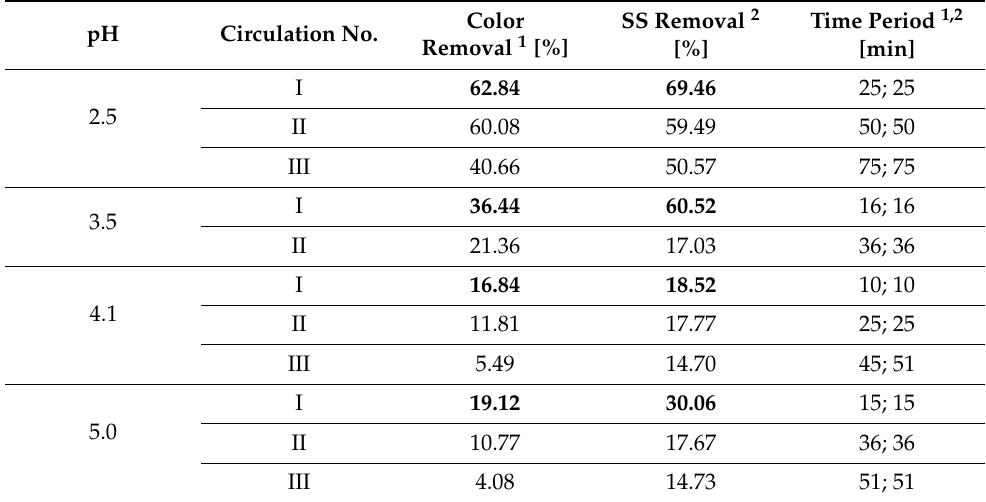
1 color removal and 2 SS removal and the corresponding time periods (for color removal-first value and for SS removal -second